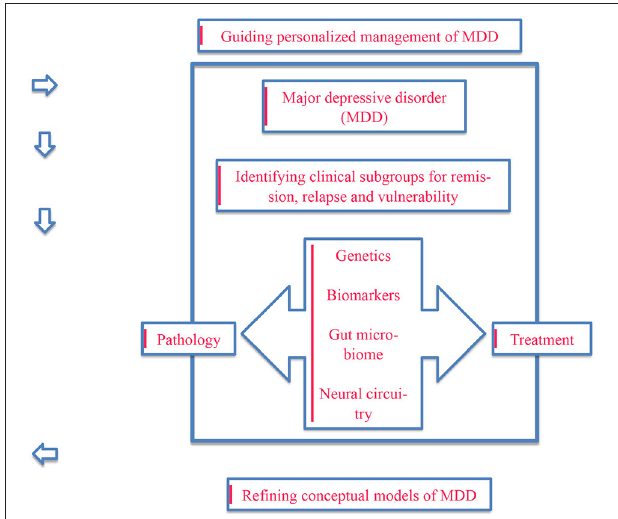
FIGURE 1 | An illustration of the key concepts focusing on the need for conceptualizing and treating major depressive disorder from a precision psychiatry perspective using multiomics